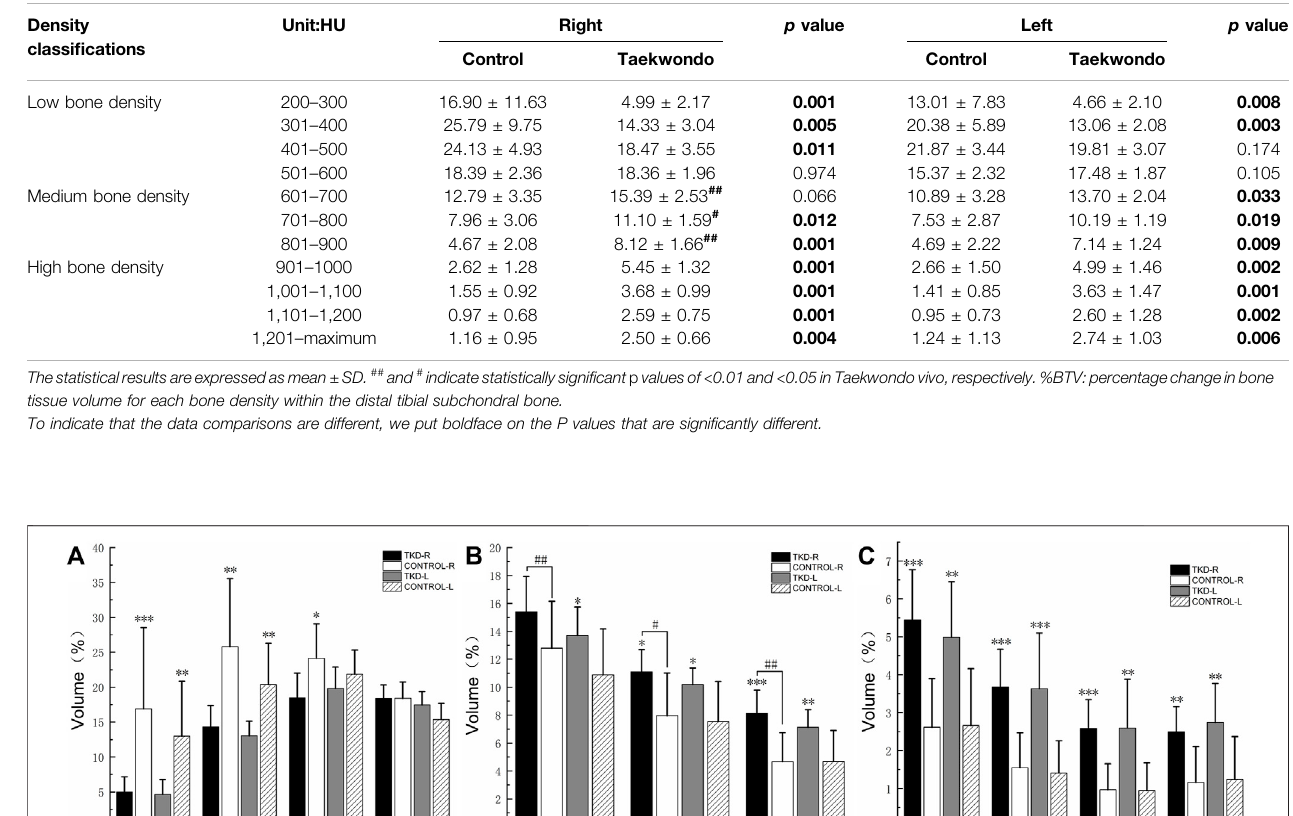
Frontiers in Bioengineering and Biotechnology |